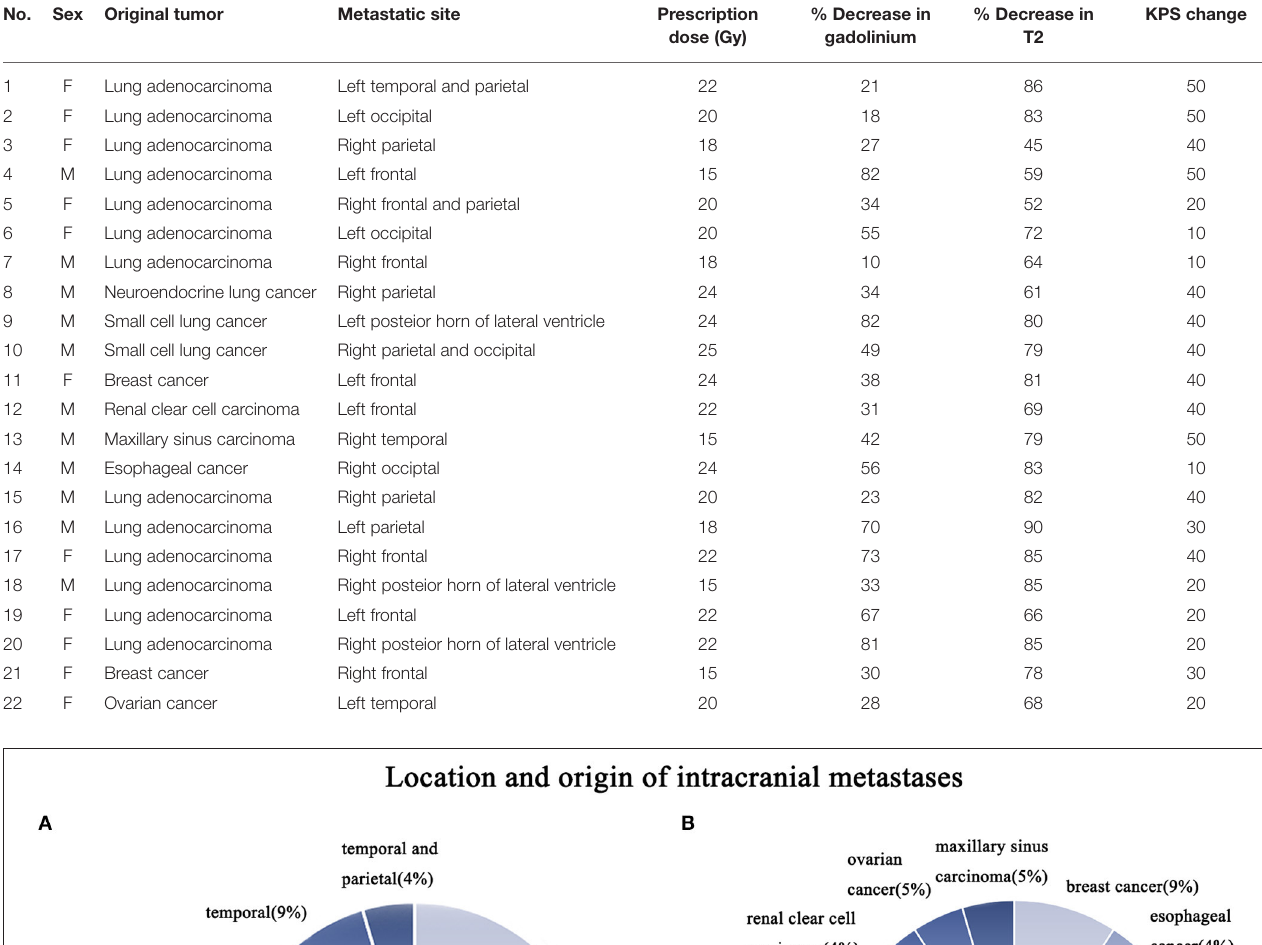
TABLE 1 | Characteristics of patients with radiation necrosis after Gamma Knife for brain metastases. No. Sex Original